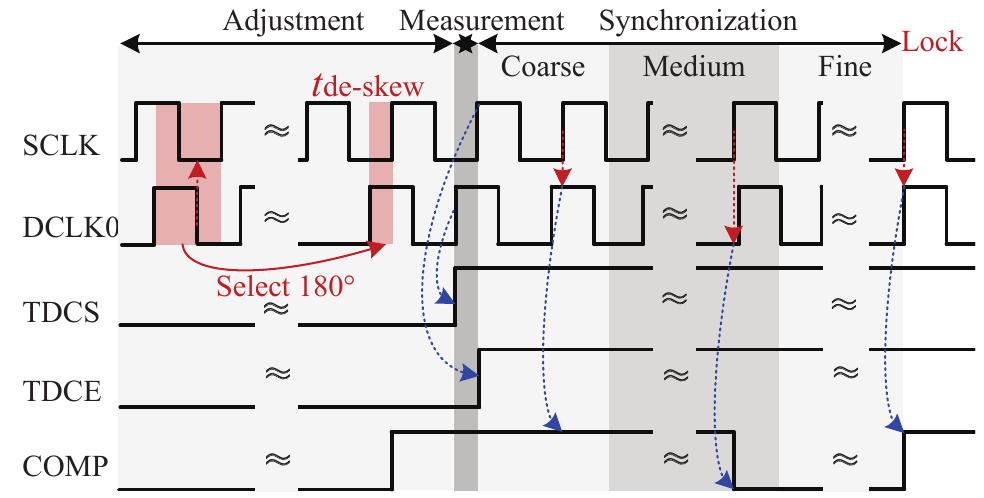
Figure 4. The timing diagram of the de-skew